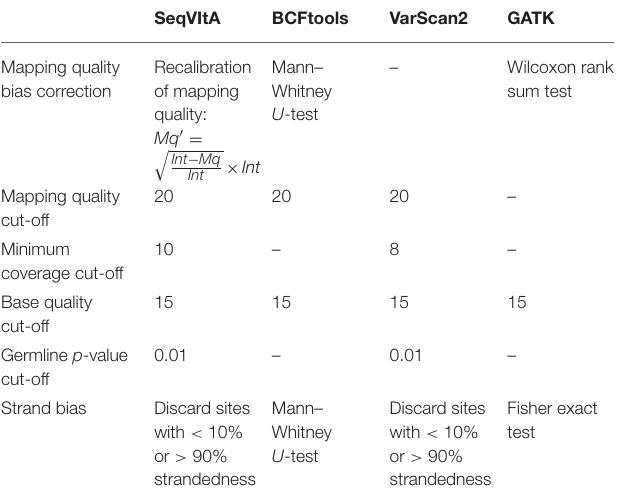
TABLE 5 | Various parameters considered for performance evaluation of SeqVItA on simulated data with three other tools. SeqVItA